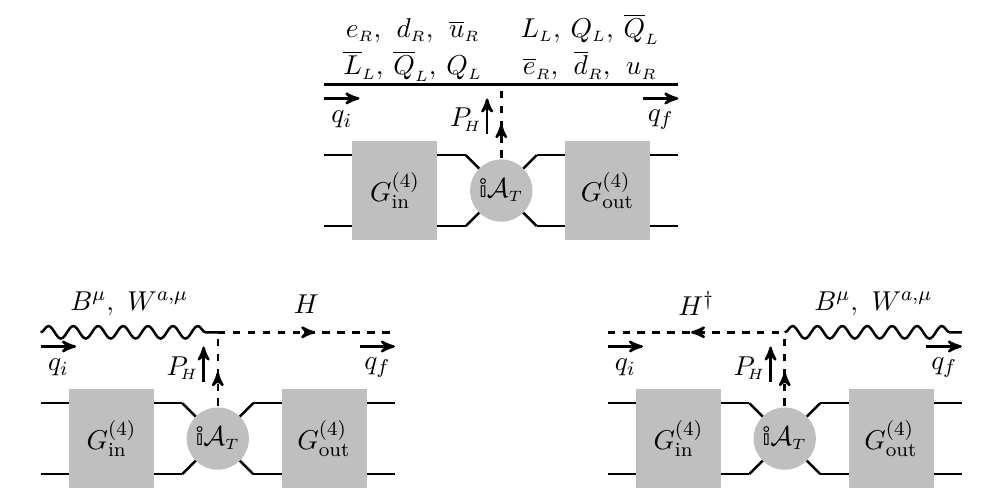
Figure 12 . Bound-state formation or bound-to-bound transitions via exchange of an off-shell Higgs doublet with the SM particles. The arrows on the field lines denote the flow of Hypercharge. All processes have their conjugate counterparts that occur via H †